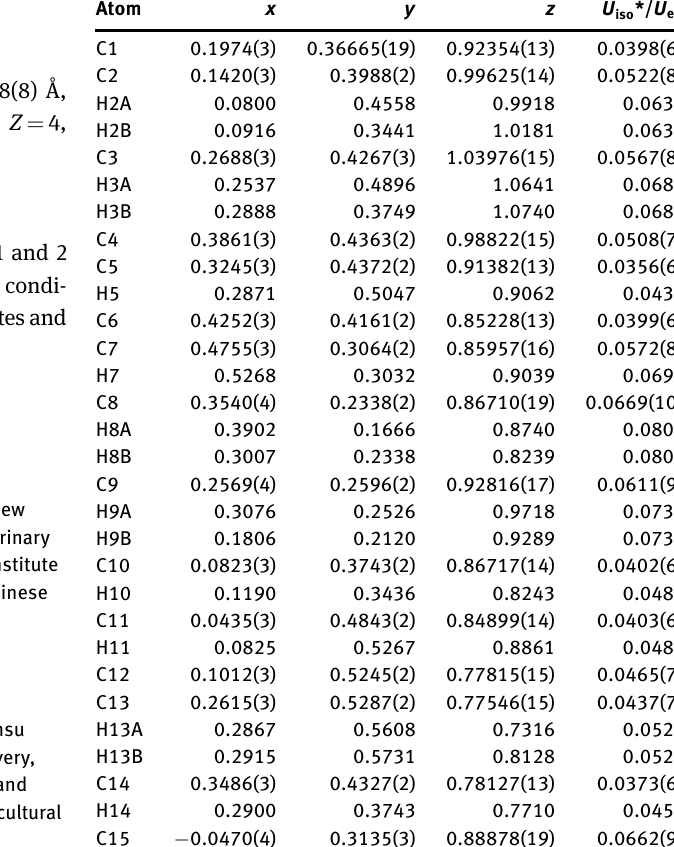
Table 2: Fractional atomic coordinates and isotropic or equivalent isotropic displacement parameters (Å 2